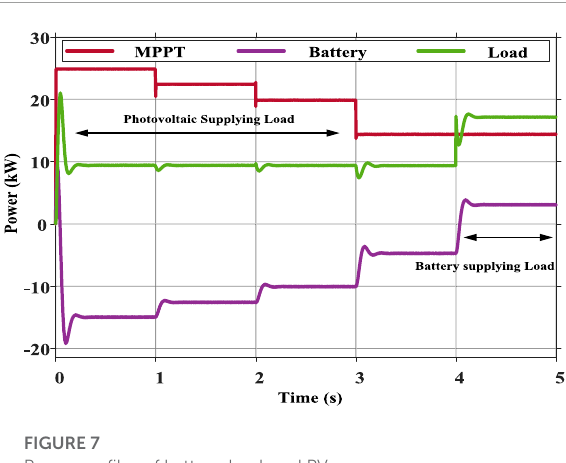
FIGURE 6 Regression plane.